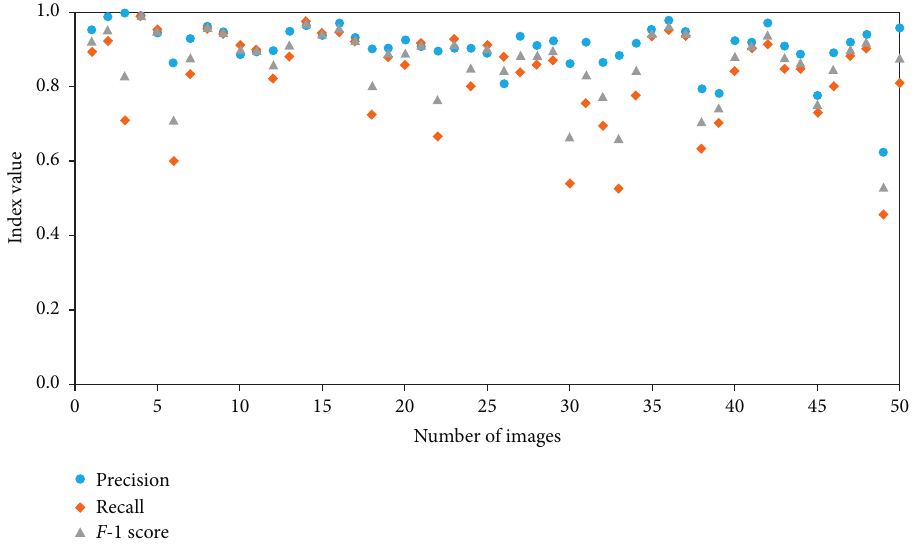
Figure 29: Three evaluation indexes of 50 images from the 200-dataset using the linear stride.